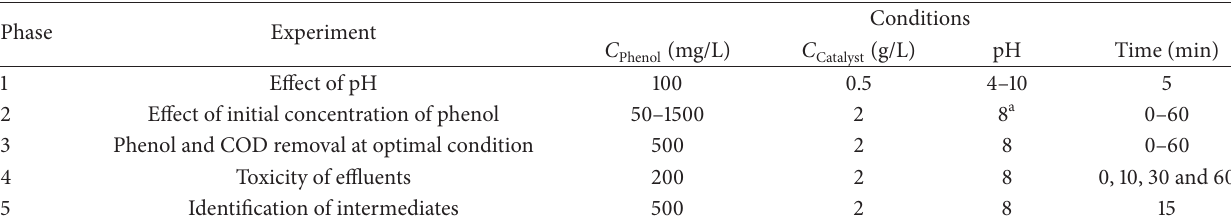
Table 1: Experimental steps and